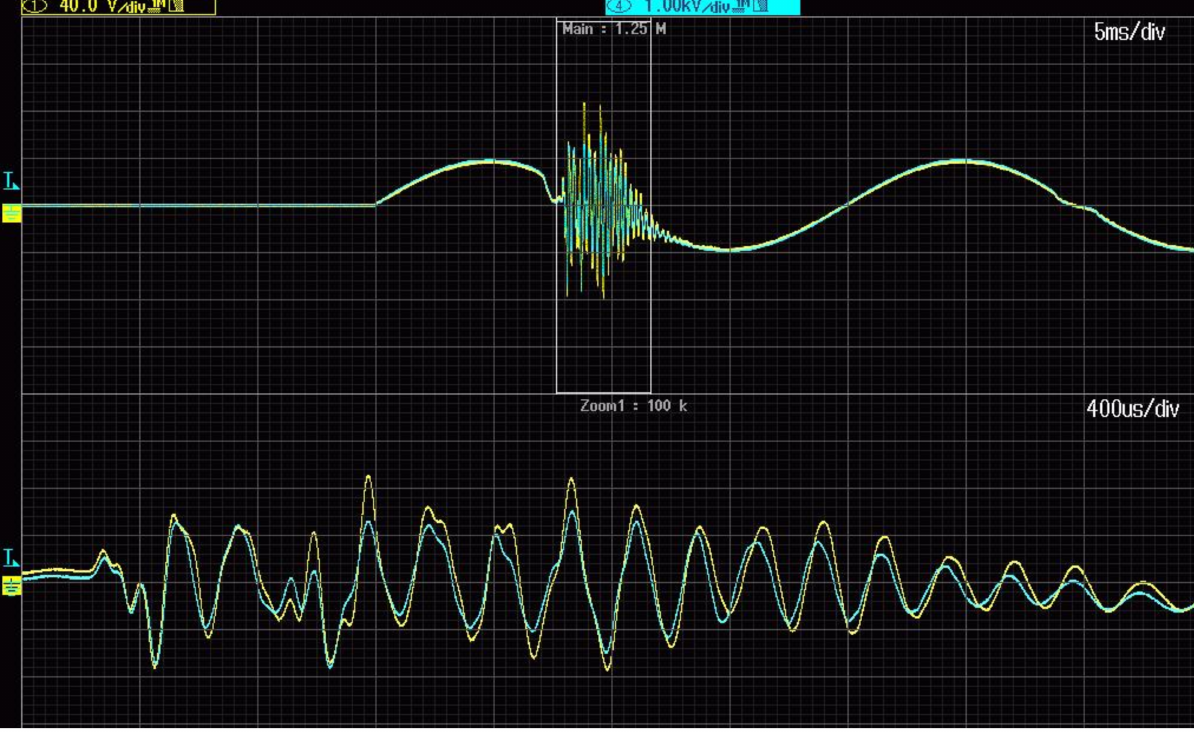
Figure 9. Voltage waveforms of voltages on primary (blue line) and secondary (yellow line) windings of the 15 kV voltage